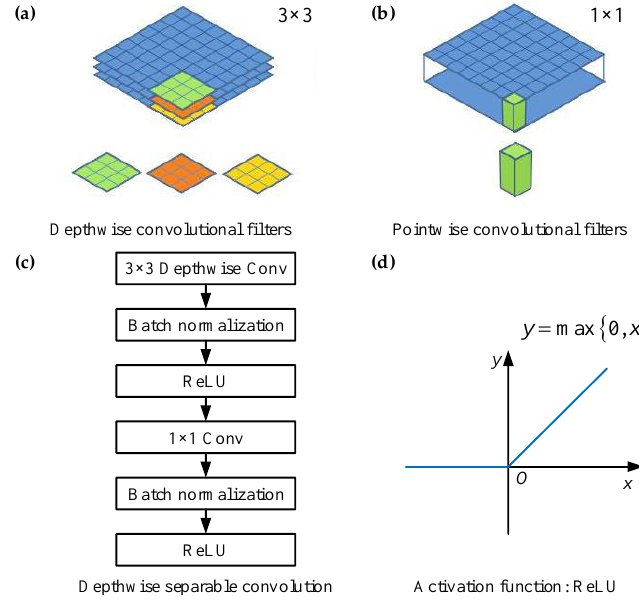
Figure 5. Depthwiseseparableconvolution. ( a )Depthwiseconvolutionalfilters; ( b )pointwiseconvolutional filters; ( c ) depthwise separable convolution; ( d ) activation function: Rectified linear unit (ReLU). Figure 5. Depthwise separable convolution. (a) Depthwise convolutional filters; (b) pointwise convolutional filters; (c) depthwise separable convolution; (d) activation function: Rectified linear unit (ReLU).